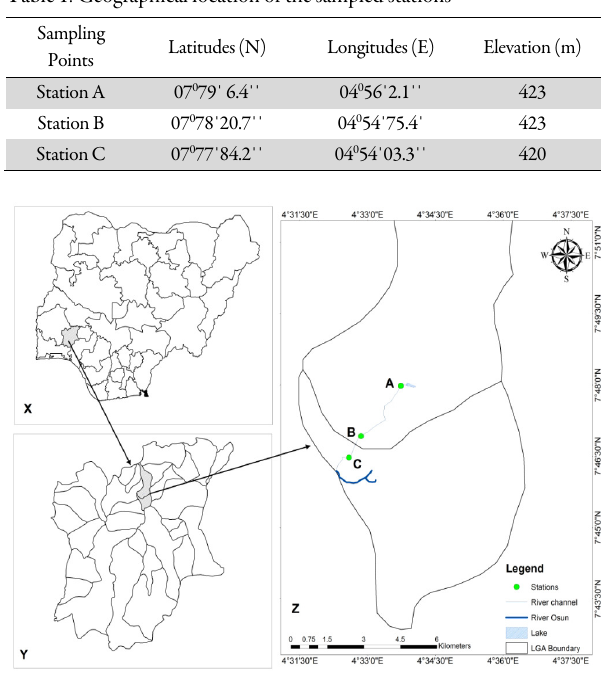
Fig. 1. (X) Map of Nigeria showing Osun State, (Y) Map of Osun State showing Osogbo and Olorunda Local Government Areas, (Z) Map showing the Lake and the sampled stations on the Saba River